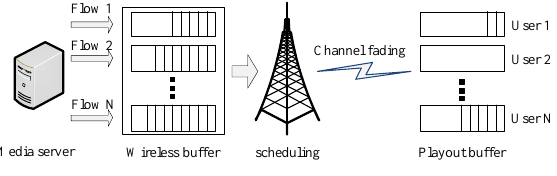
Figure 2: Media streaming system in LTE networks The wireless buffer and the playout buffer work in a tandem way, which means that the departure process of a user in the former is exactly the arrival process in the latter. How- ever, they work at the different time scales and at different layers. The wireless buffer works at the bit level due to the bit loading in the lower layers, and the playout buffer works at the video frame level.